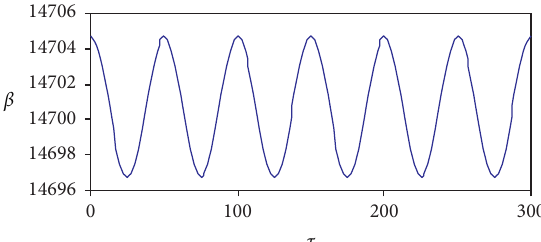
Figure 18: The stability phrase Θ ′ and Θ for case (i) in Section 4.2.